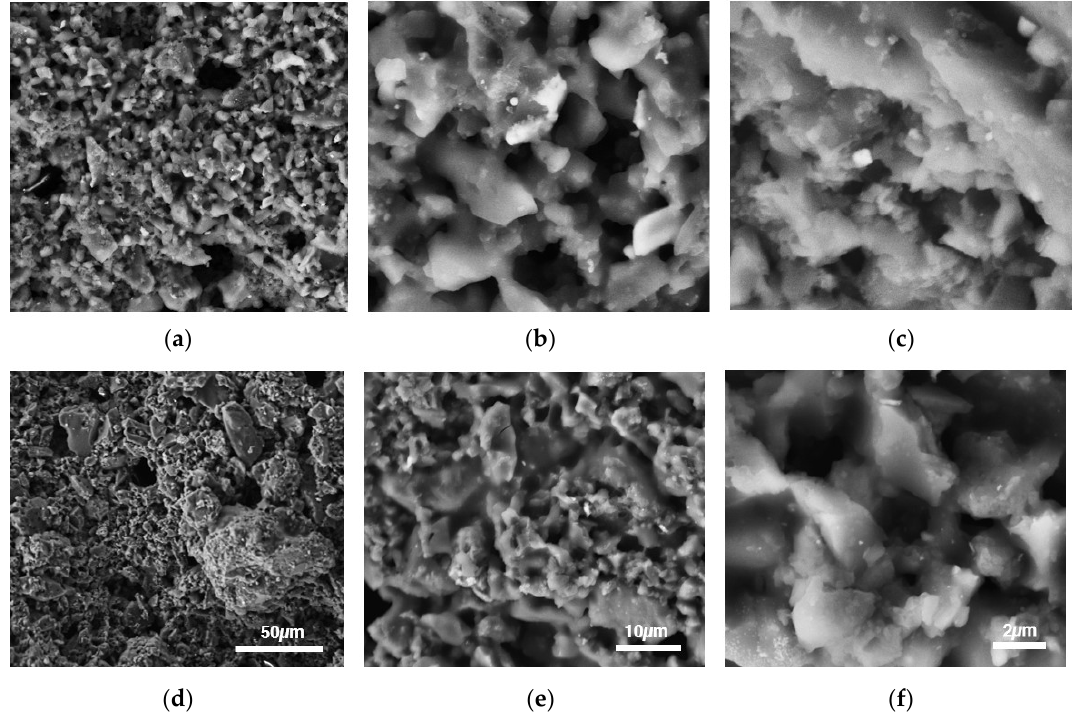
Figure 7. Scanning electron microscopy ( SEM) pictures of the ACC before ( a – c ) and after ( d – f ) the application of 7 kV for 3 h at different magnification.